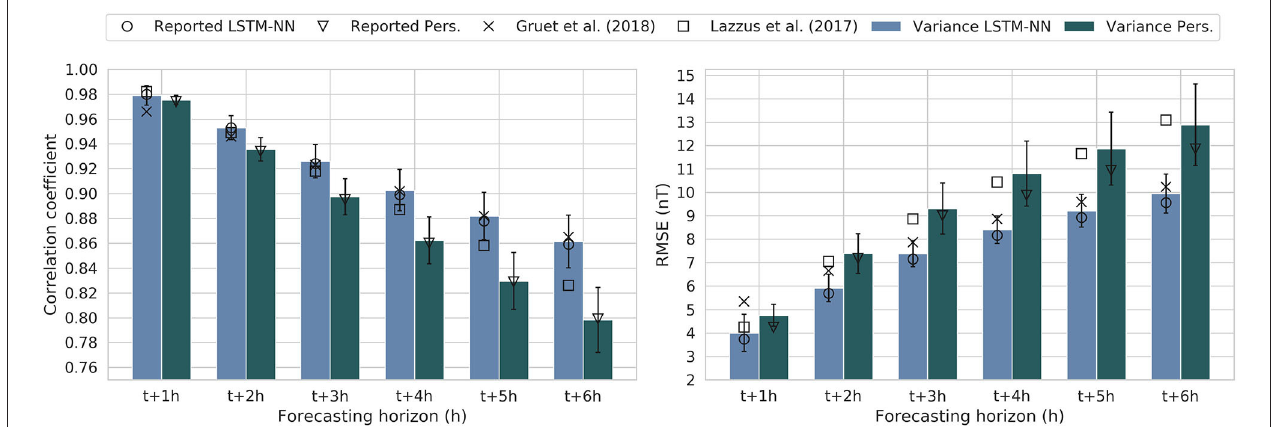
FIGURE 2 | Using 10-fold cross validation, the LSTM-NN model and persistence model were evaluated for 10 different training and test sets with the RMSE and correlation coefficient to determine the impact of the choice of set on the performance. The left figure displays the correlation coefficient, whose values we want to have as close to 1 as possible. The right figure displays the RMSE, whose values we want to minimize. The circle and triangle display the values reported in Table 1 , the bars and error bars respectively display the mean and variance of the performance of the 10-fold cross-validation, and the square and cross display the performance of the models reported by Lazzús et al. (2017) and Gruet et al. (2018), respectively. All of these values are also summarized in Table 2